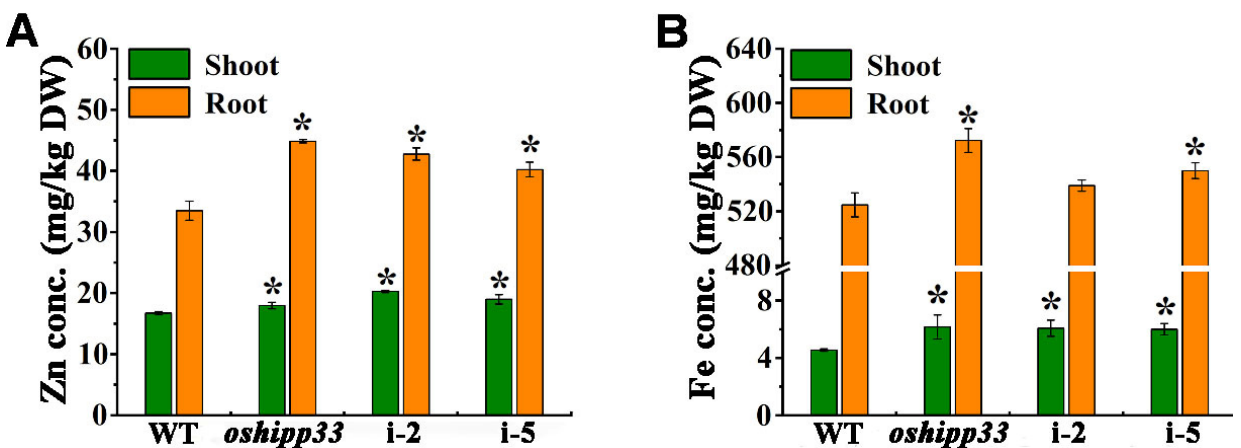
Figure 7. Analysis of Zn and Fe concentrations in OsHIPP33 mutant, RNAi lines and wild-type (WT) treated with excess Zn and Fe. ( A ) Zn concentrations in shoot and root with 500 µ M Zn supply. ( B ) Fe concentrations in shoot and root with 1000 μ M Fe supply. The vertical line indicates the error bar and the asterisks indicate a significant difference between the mutant lines and WT ( p < 0.05).